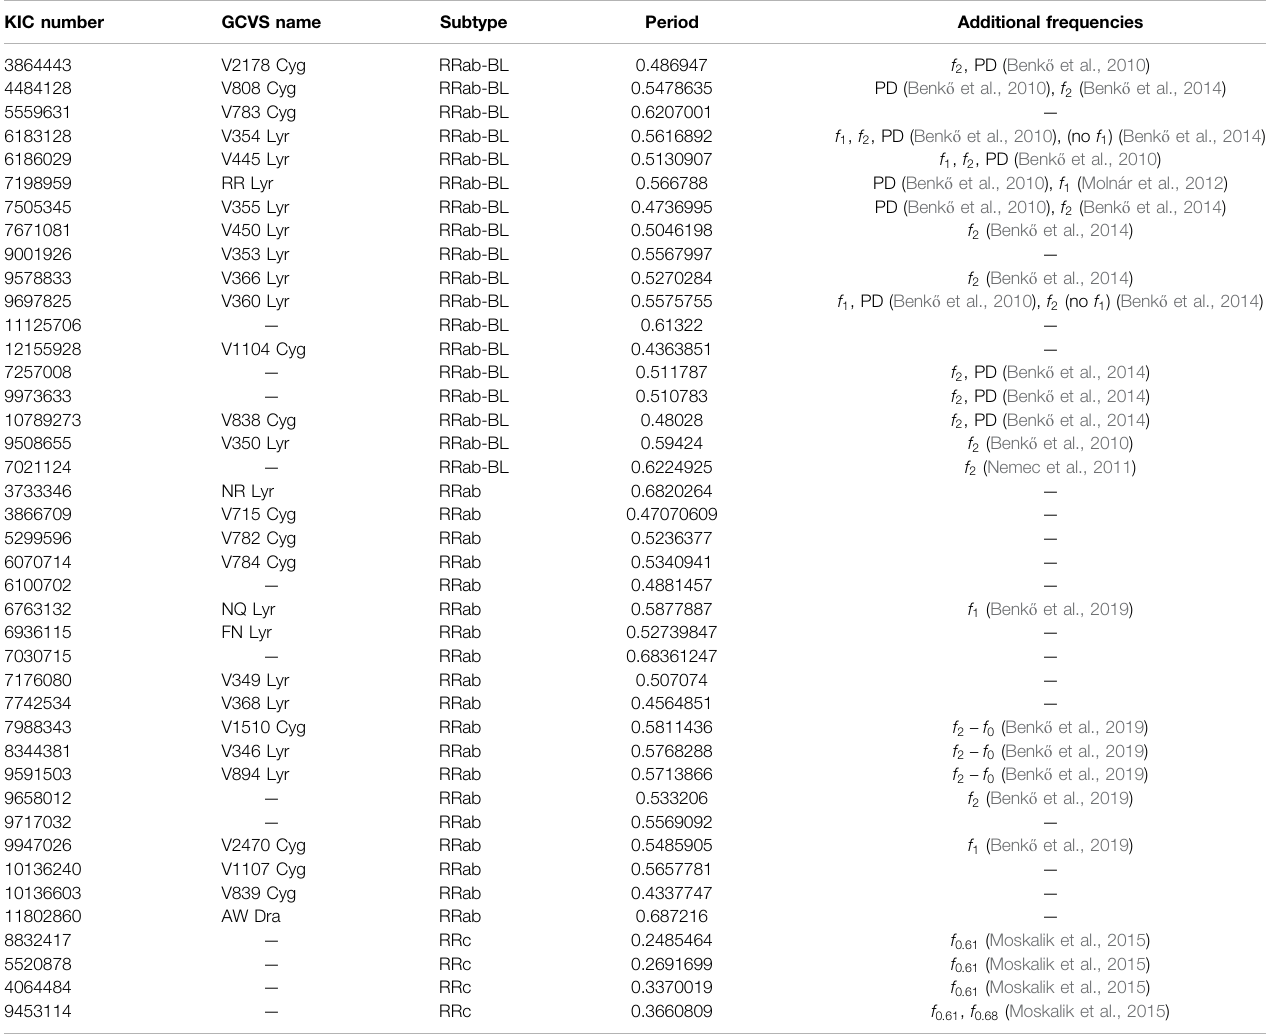
TABLE 1 | Additional modes in the Kepler RR Lyrae stars. KIC